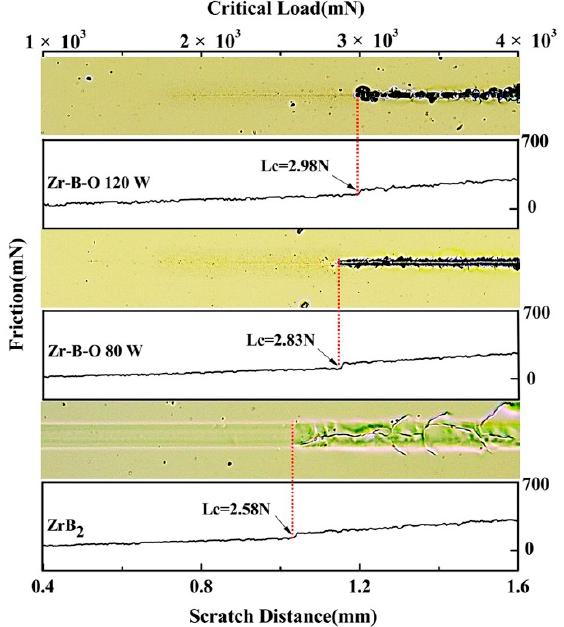
Figure 6. Indentation morphology and critical fracture load of ZrB 2 monolayer and Zr-B-O nanocomposite films (80 and 120 W power of ZrB 2 target).